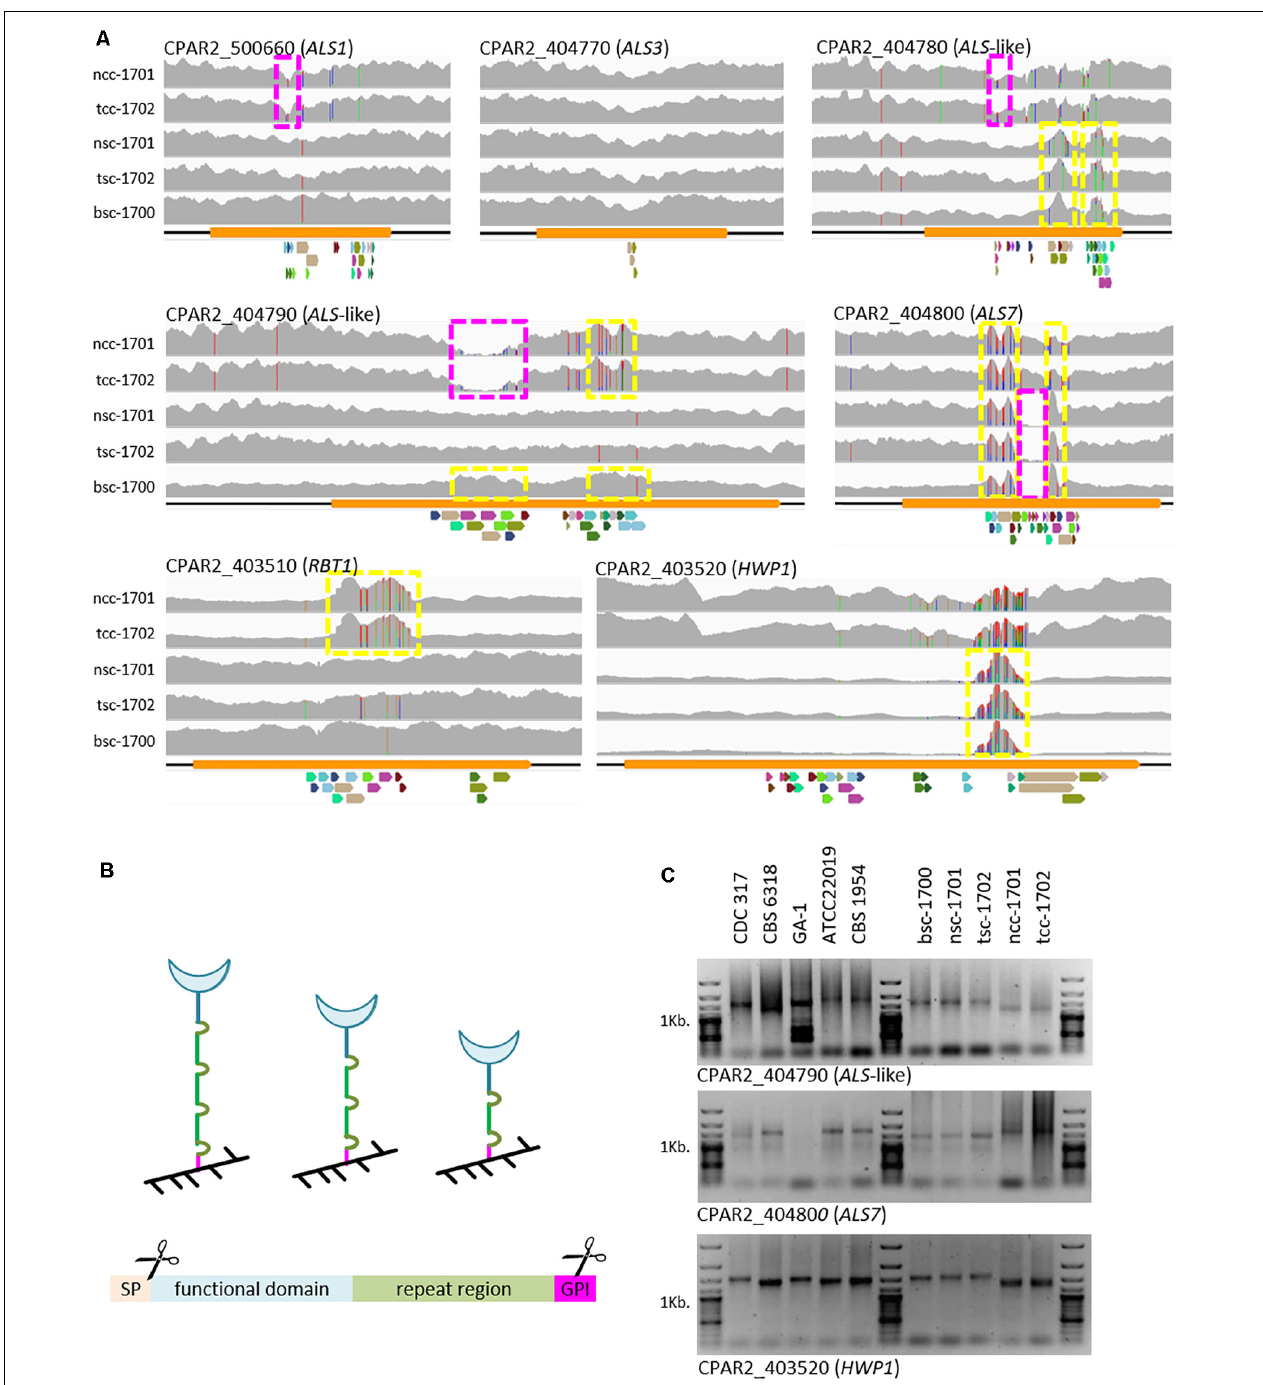
FIGURE 4 | Variations in cell-wall-protein encoding genes. (A) Raw Illumina reads mapped onto the CDC-317 reference sequence and counted (gray, y -axis auto-scaled to accommodate highest read count). SNPs indicated by red, green, blue, or orange vertical dashes. Yellow boxes: increased read numbers, indicating repeat number extension; purple boxes: reduced read numbers indicating repeat number reduction. Repeats illustrated below each panel, where colors are conserved only within a panel. (B) GPI-cell wall proteins are covalently linked to the cell wall (black) through the C-terminal GPI domain (pink). Number variations in the repeat region (green) are thought to in- or de-crease exposure of the functional domain (blue) at the cell surface. GPI-linked cell wall proteins consist of at least four distinct domains, namely an ER-signal peptide (cleaved off), a functional domain, a repeat region, and a GPI-linkage domain (internally cleaved during anchor attachment). (C) Selected PCR amplicons of repetitive regions in CPAR2_404790, CAPR2_404800, and HWP1 confirm the different lengths of the repeat regions, as suggested by whole genome